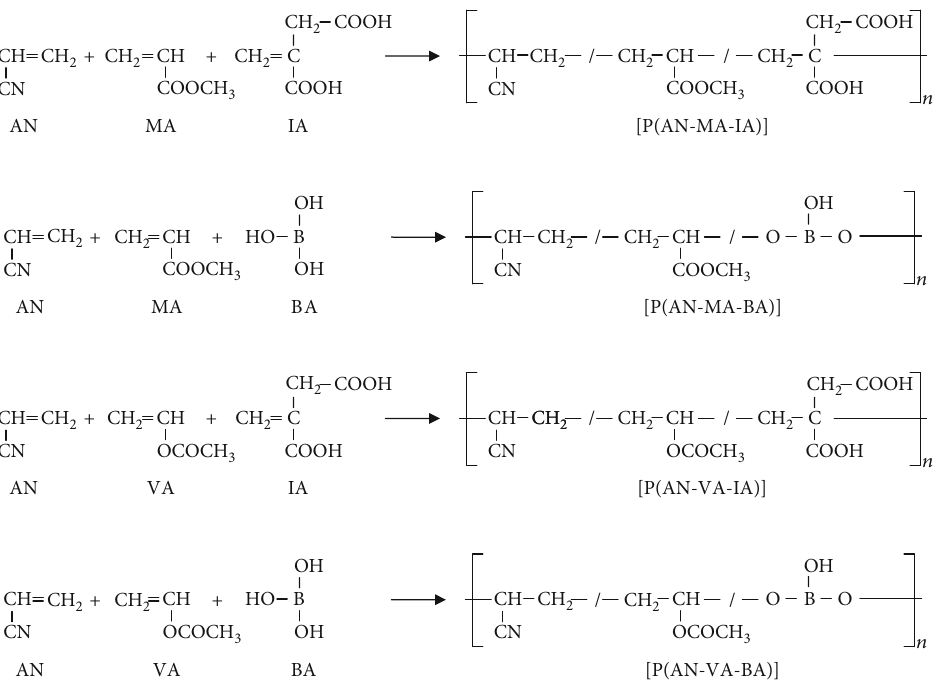
Figure 1: Reactions of PAN terpolymerization used in this